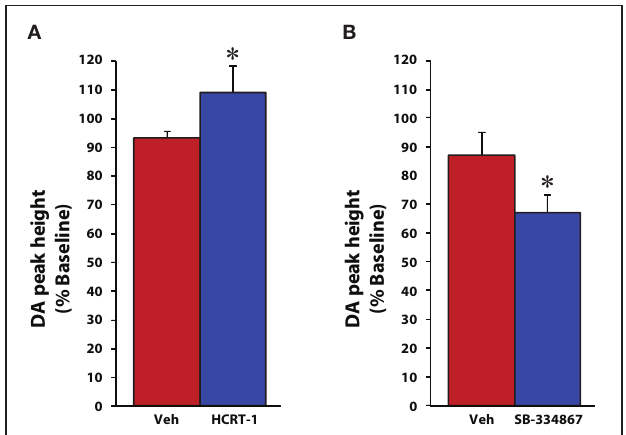
FIGURE 1 | Hypocretin manipulations influence evoked dopamine release under baseline conditions. Shown are the mean ± SEM of peak heights of stimulated dopamine (DA) release for rats that received (A) vehicle ( n = 6) or 1nmol hypocretin-1 ( n = 6) into the VTA, or (B) vehicle ( n = 8) or 10nmol SB-334867 ( n = 6) into the VTA. Compared to vehicle, hypocretin-1 increased, while SB-334867 reduced the peak height of stimulated dopamine release in the NAc core. ∗ P < 0 . 05 relative to vehicle. Modified from España et al. (2010,